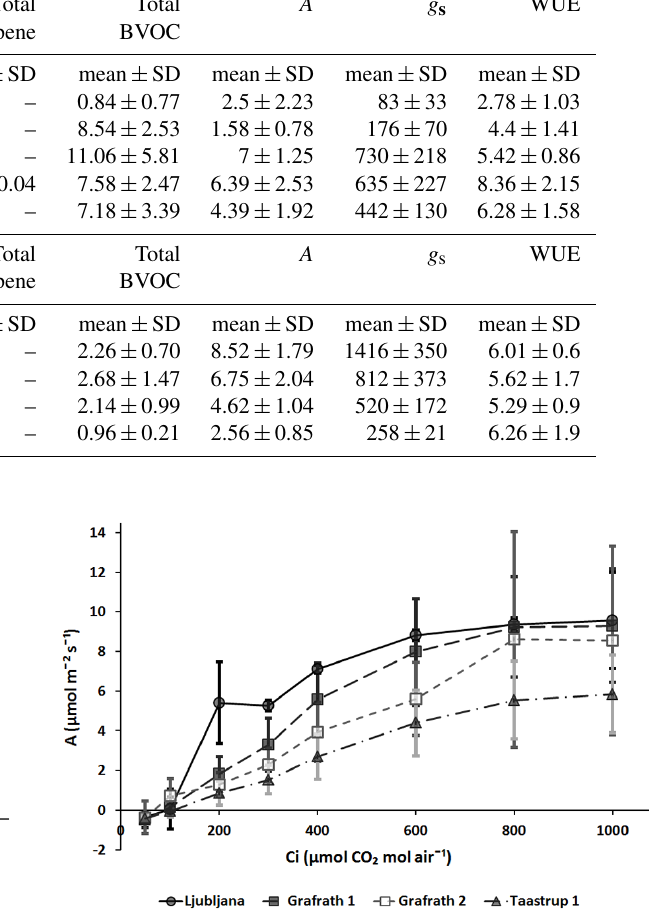
Figure 3. Net assimilation rate A and intercellular CO 2 concentra- tion ( C i ) response curves for English oak. The figure represents the average A - C i response curves for each tree ± SD.